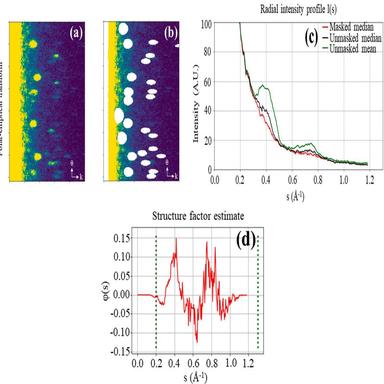
Radial distribution function of the SiOC sample. (a) A calculated radial integral via the polar-elliptical method, without a mask, (b) a calculated radial integral via the polar-elliptical method, with a mask, and (c) radial intensity profiles calculated from (a) and (b), (d) estimated structure factor.